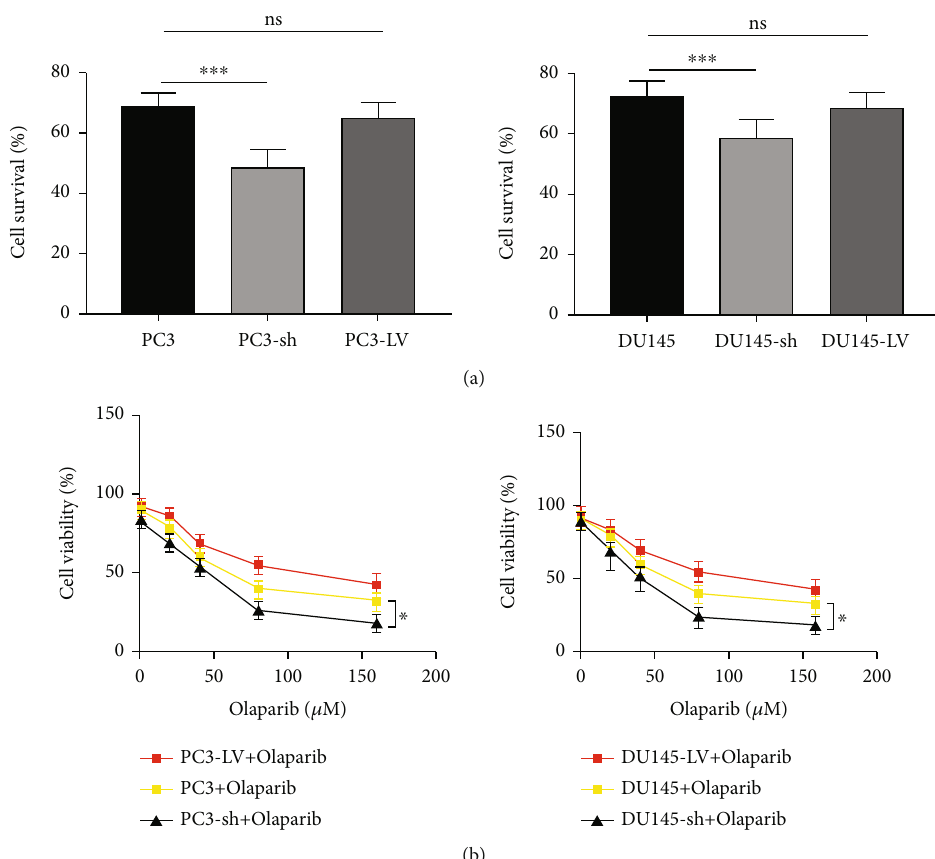
Figure 5: Relationship between the MUS81 expression and the sensitivity to Olaparib. (a) CRPC cell viability after 80 μ M Olaparib treatment. (b) Cell viability of PC3, PC3-LV, PC3-sh, DU145, DU145-LV, and DU145-sh cells at 3 × 10 3 cells/well following Olaparib treatment at several concentrations for 48 h by CCK-8 assay. ∗ P < 0 : 05 and ∗∗∗ P < 0 : 001